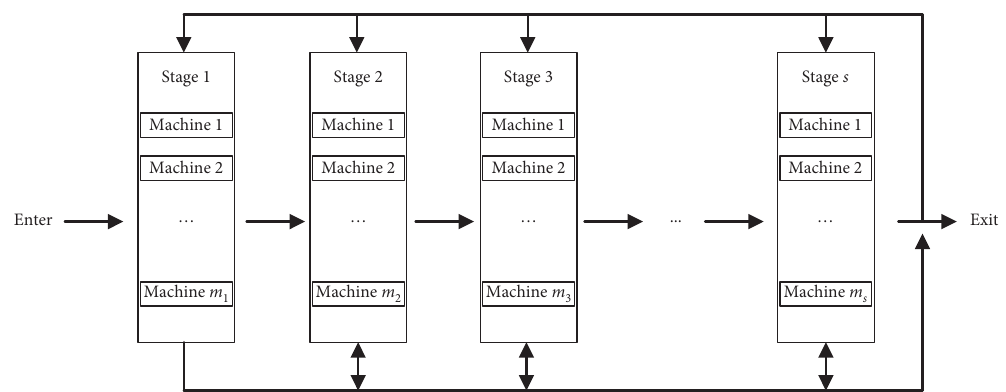
Figure 1: Diagram of RHFSP with unrelated parallel